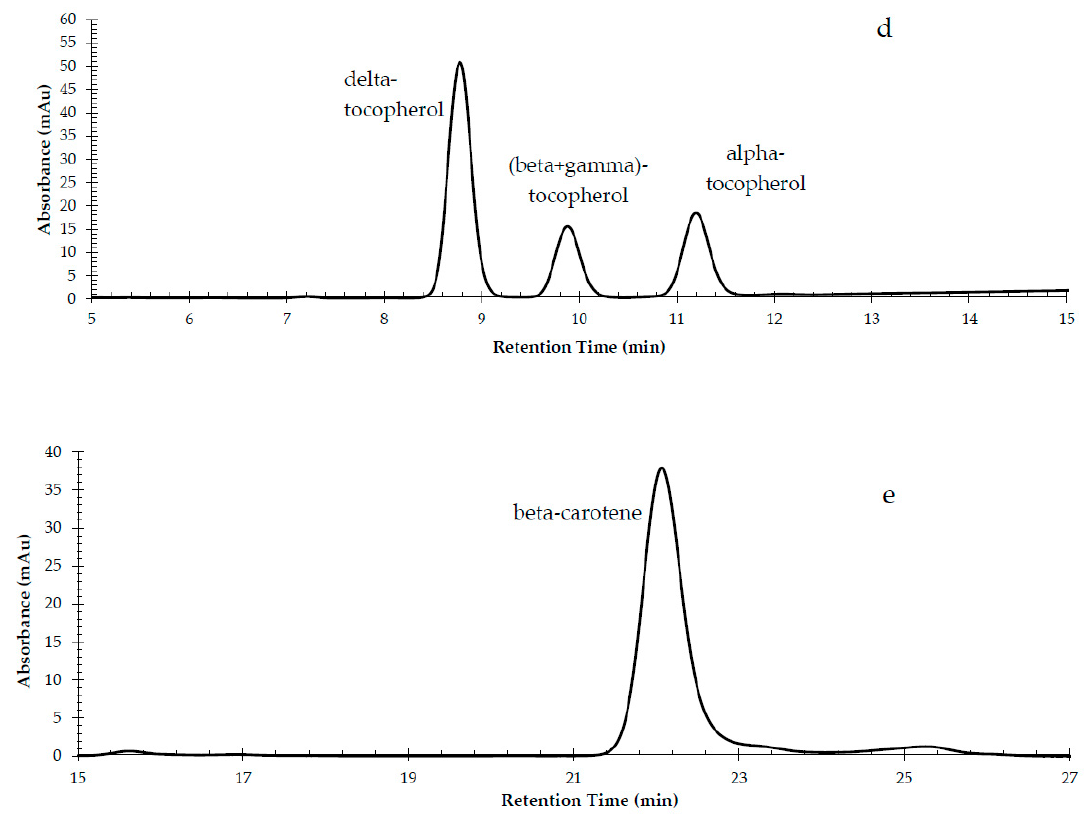
Figure 1. Chromatogram of a mixed standard solution of ( a ) lutein 1 mg/L, ( b ) chlorophyll a and a’ 10 mg/L, ( c ) squalene 250 mg/L, ( d ) δ -tocopherol 50 mg/L, ( β + γ )-tocopherol 25 mg/L, α -tocopherol 25 mg/L, and ( e ) β -carotene 5 mg/L.